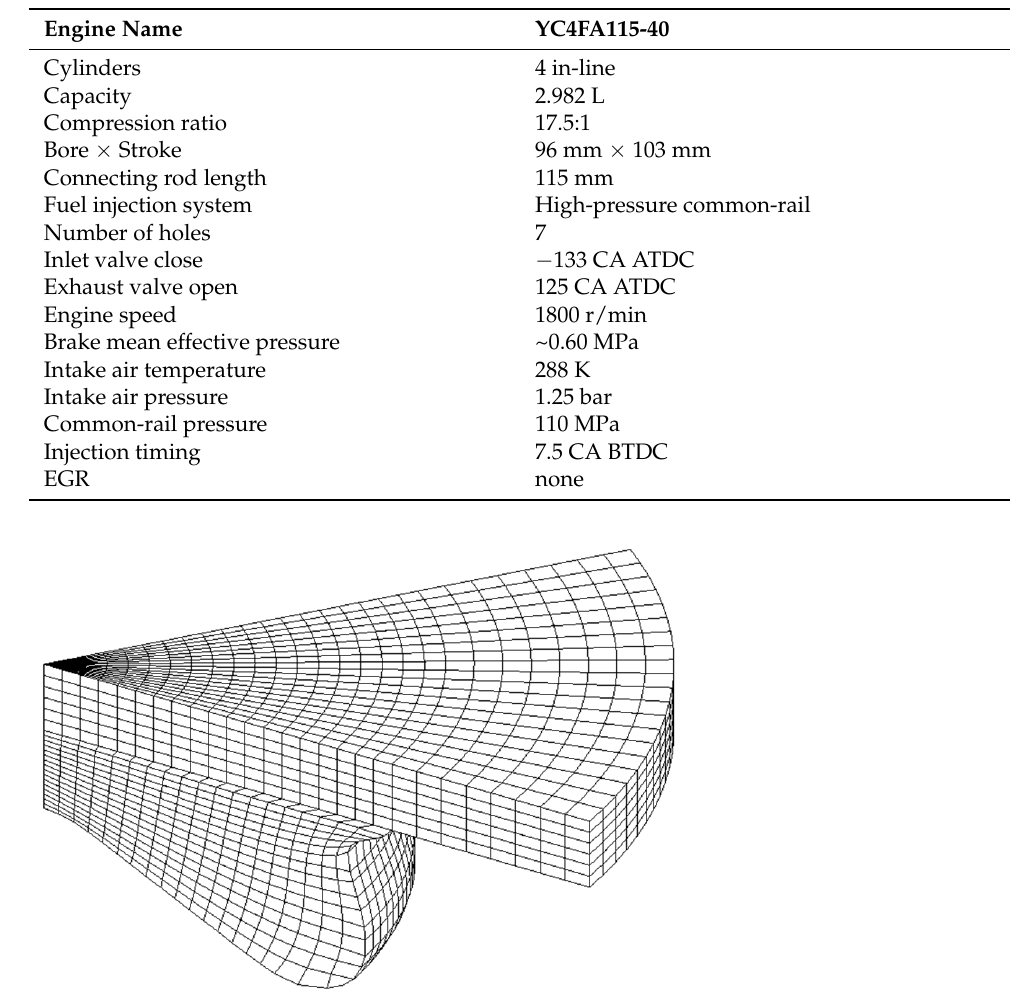
Table 3. Engine specifications and operating conditions.